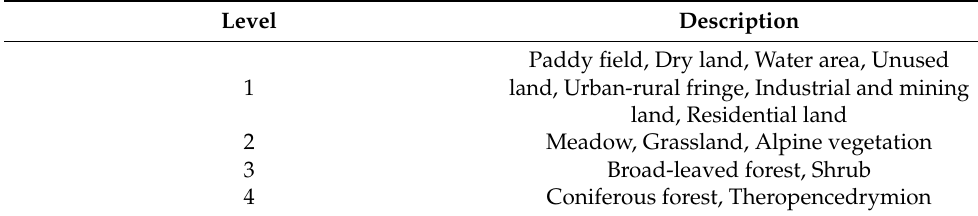
Table 2. Classification of Land-Usage